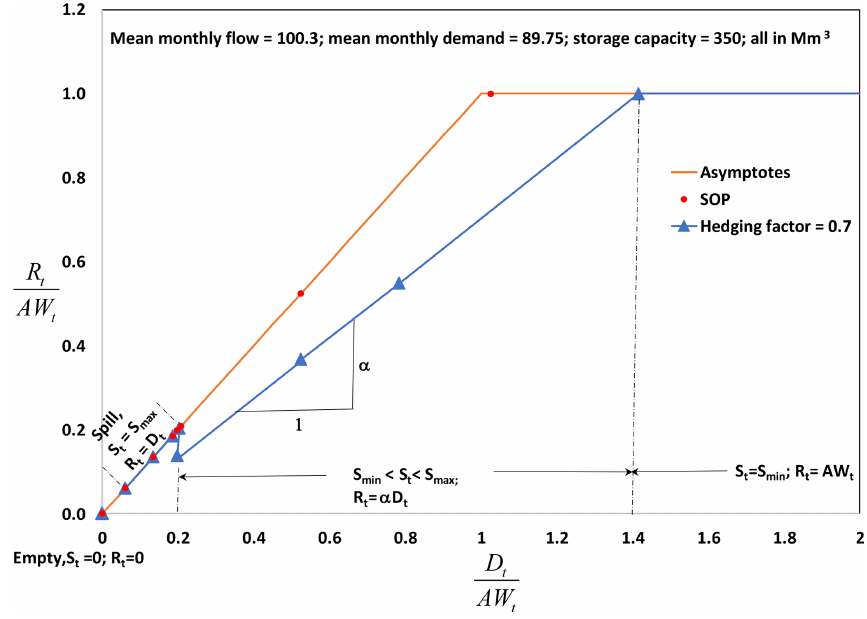
Figure 4. Modeling hedging policy of reservoir operations in the Budyko supply and demand framework. The standard operating pol- icy (SOP) corresponds to the asymptotes. For the hedging rule, delivery or release is “actual”, available water is “supply”, and human use is “demand”. For demonstration purposes, a linear function is assumed for the hedging rule (i.e., R t = αD t ). The storage conditions are indicated for the hedging policy